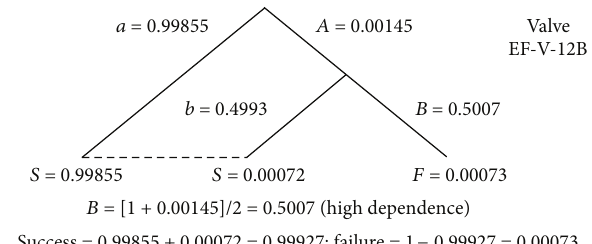
Figure 2: Dependence between teams that operate EF-V-12A and EF-V-12B